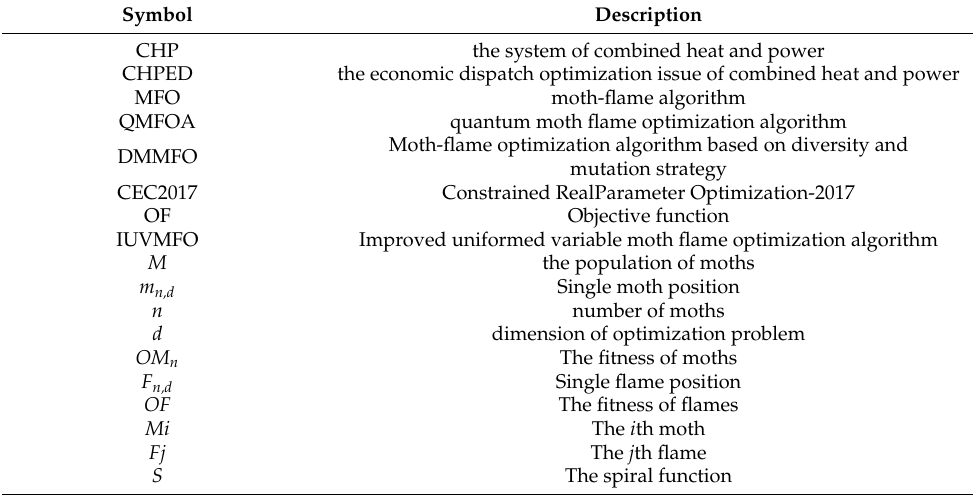
Table A1. Description of